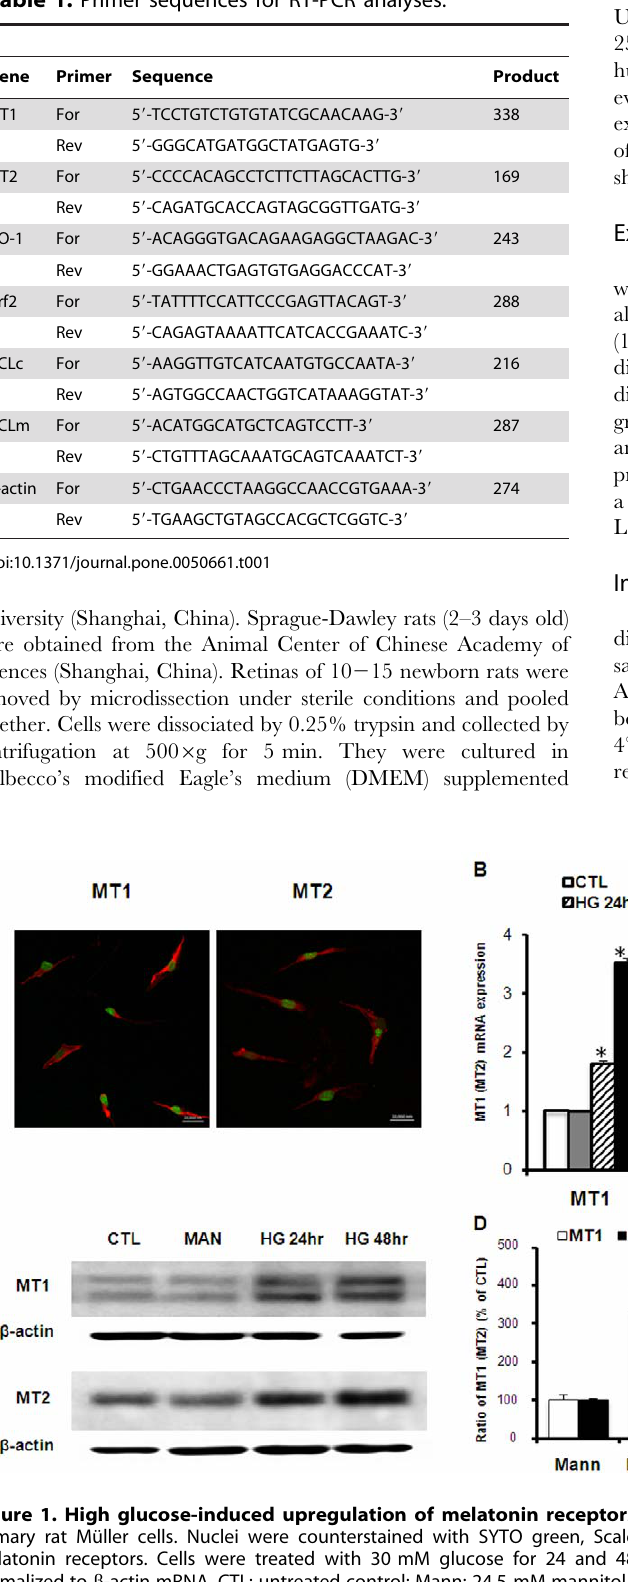
Table 1. Primer sequences for RT-PCR analyses.